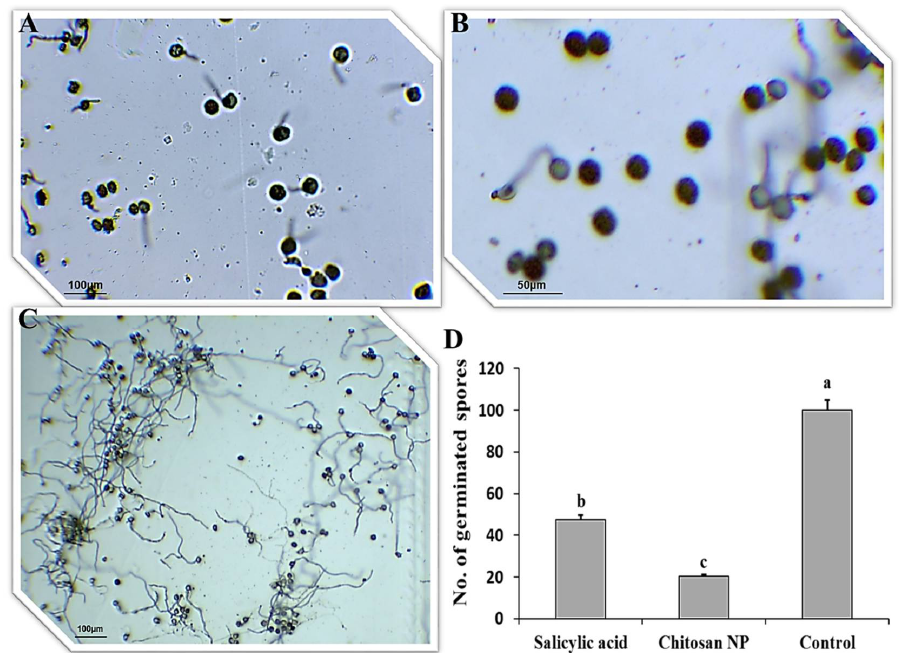
Figure 1. Puccinia triticina spore germination on water agar media with two treatments; salicylic acid ( A ), chitosan nanoparticles ( B ) and control non-treated ( C ) and the number of germinated spores ( D ). The letters (a, b and c) denote significant difference.